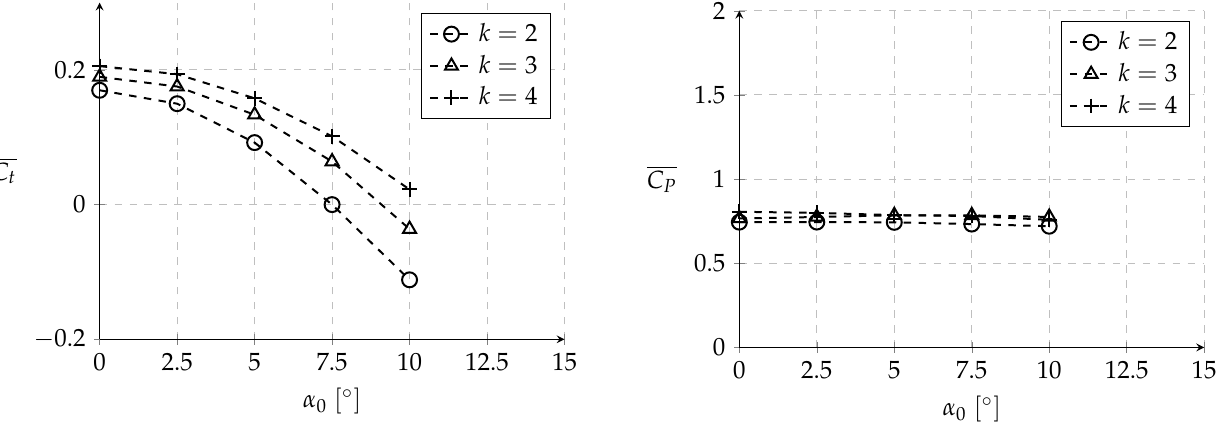
Figure 11. Mean thrust and power coefficients as a function of α 0 at St =